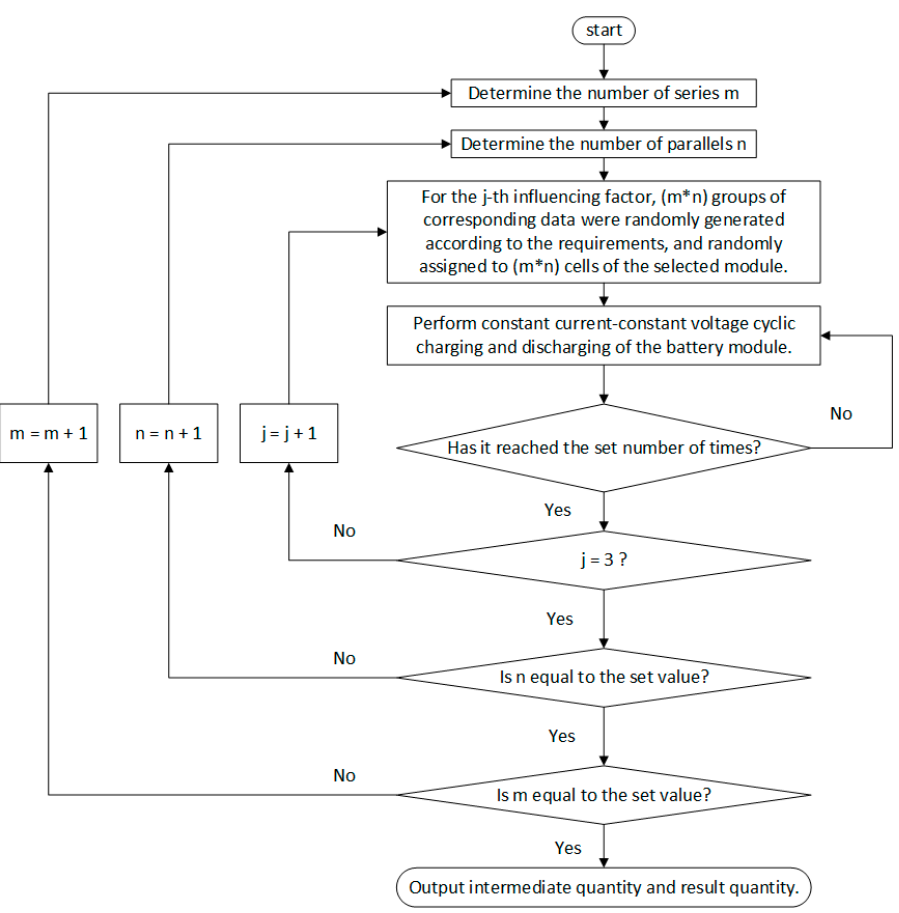
Figure 3. Steps of